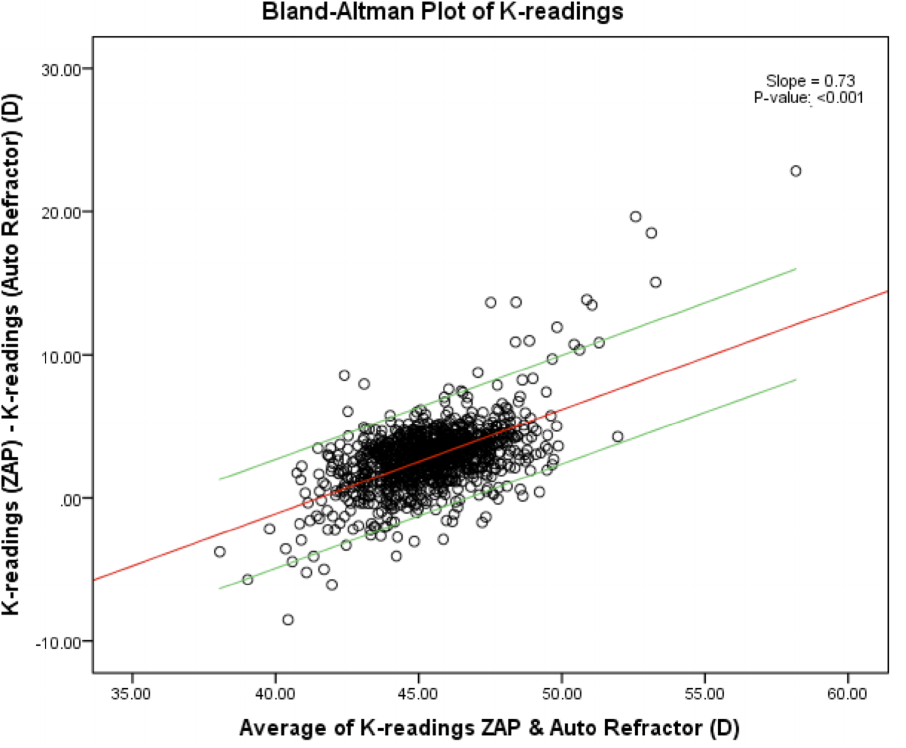
Figure 3. Bland-Altman plot of keratometric (K)-readings with the difference between the K-readings of the two methods regressed on the average of K-readings with its 95% prediction interval. X-axis units=D/Y-axis